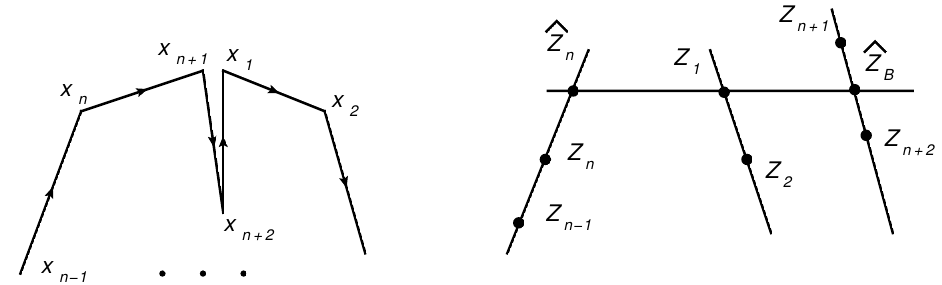
Figure 10 . Forward limit in momentum and momentum twistor space. In momentum space we are gluing x n +1 with x 1 while keeping x n fixed in such a way that x 2 this equivalent to gluing Z n +1 and Z n +2 with ˆ Z B . The same is also true for their supersymmetric